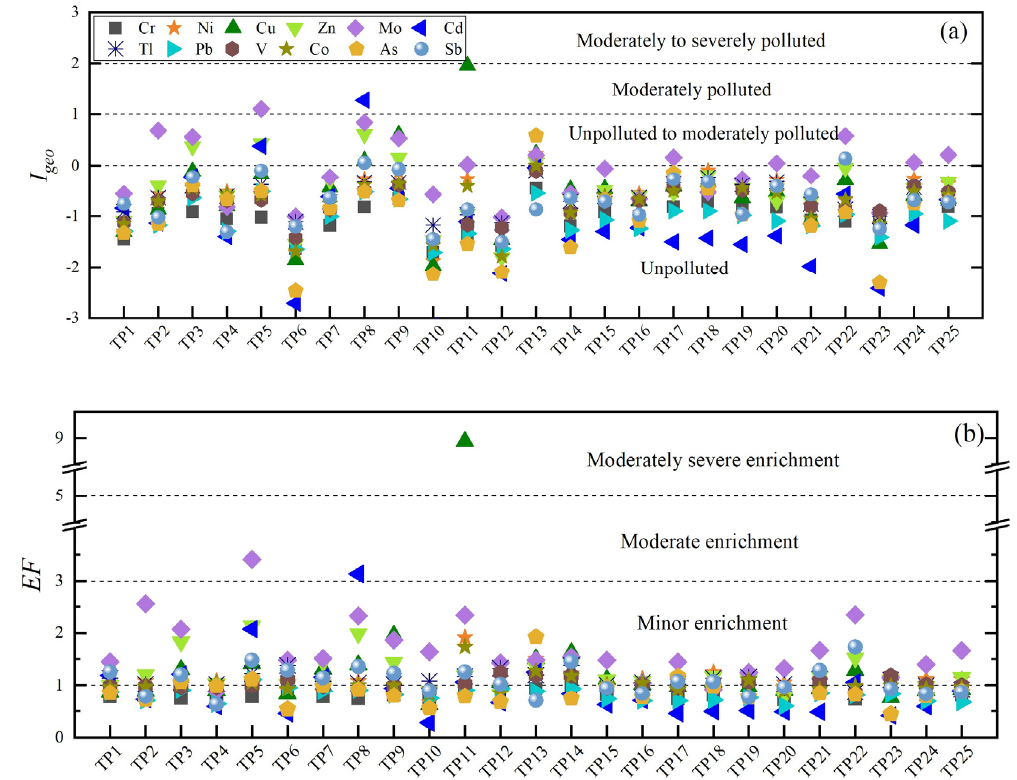
Figure 3. ( a ) Geoaccumulation index ( I geo ) of PTEs in surface sediments of the Taipu River; ( b ) enrichment factor ( EF ) of PTEs in surface sediments of the Taipu River.